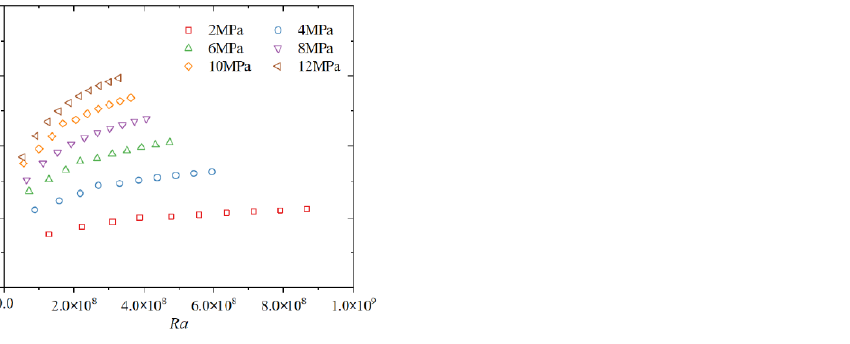
Figure 13. Relationship between the Ra and Nu in supercritical helium natural convection.